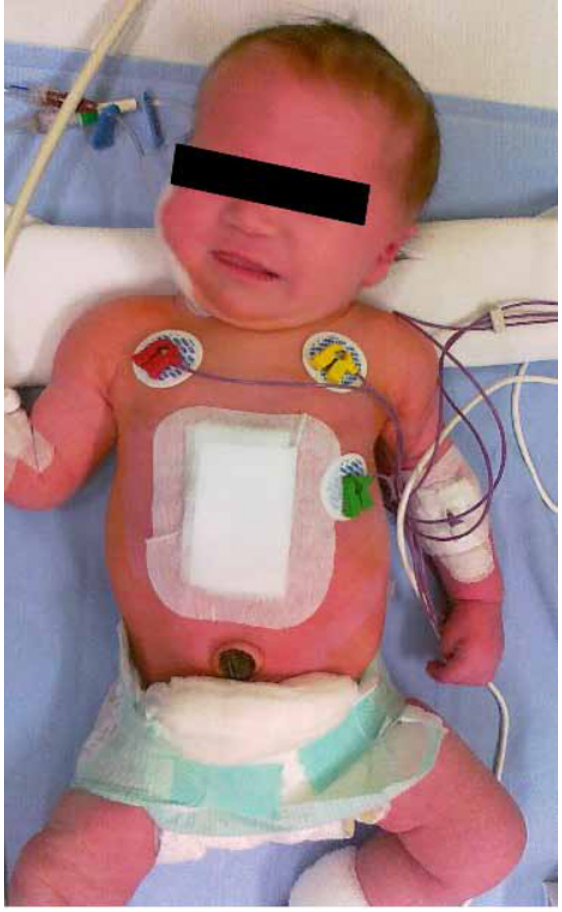
Figure 2. Physical examination of baby revealed a phenotypically abnormal neonate with reddish skin.